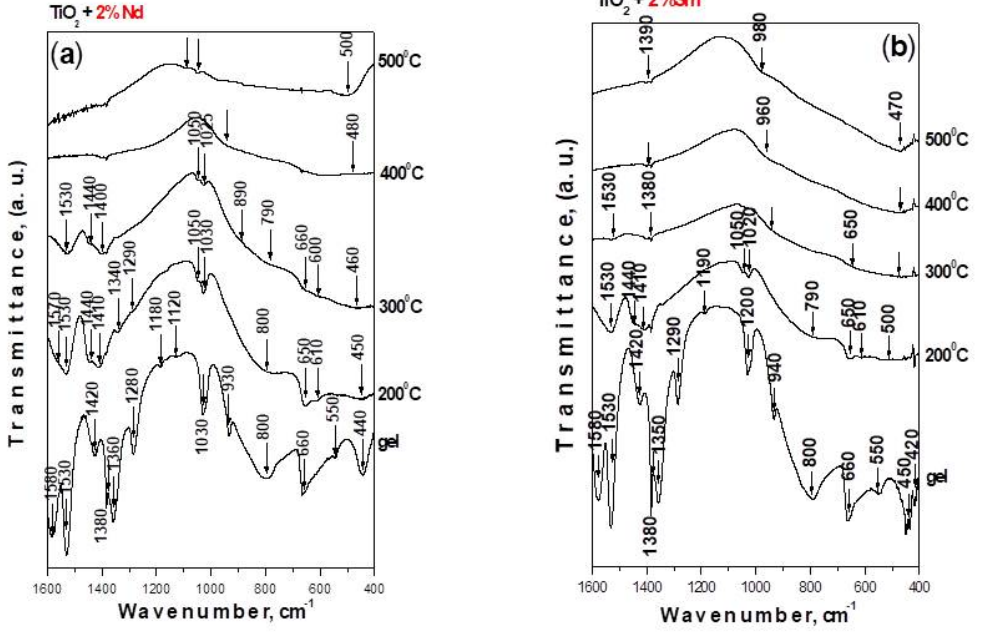
Figure 5. IR spectra of Ti(IV) isopropoxide modified with ( a ) 2% Nd and ( b ) 2% Sm. UV-Vis